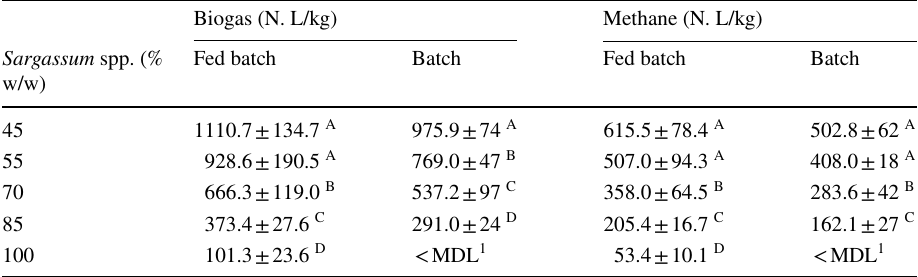
Different letters within each column indicate a significant difference between experimental units for the unpaired t test (alpha